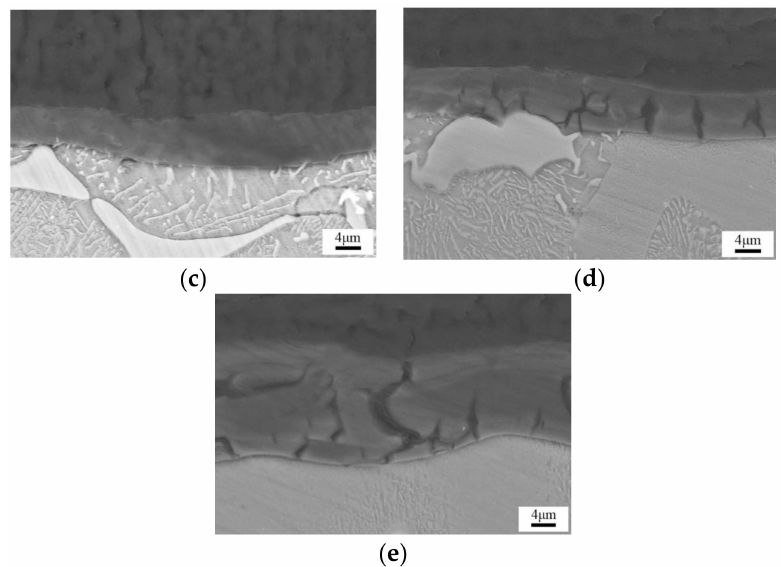
Figure 3. Cross-sectional morphologies of the LDHs coatings at different formation times; ( a ) 10 min,